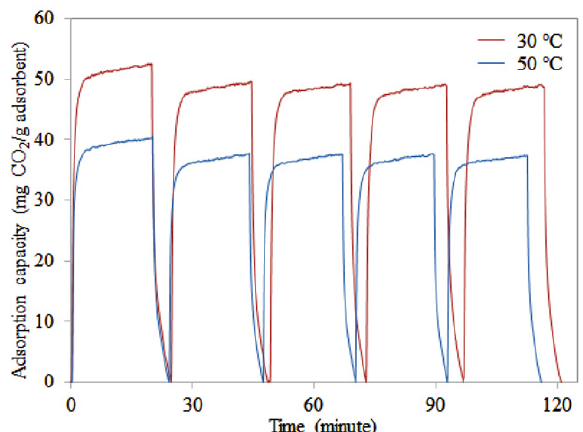
Figure 9. Five cycles of CO 2 capture at adsorption temperature of 30 and 50